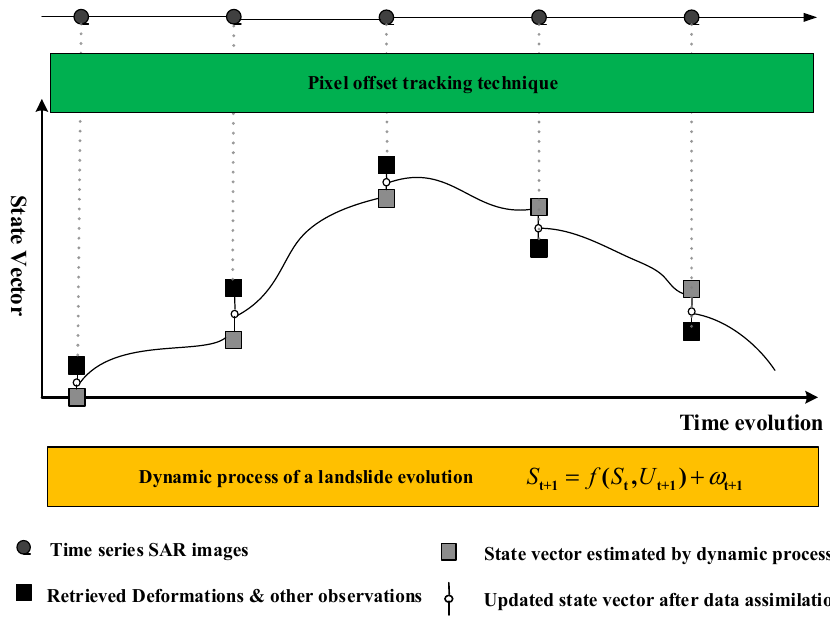
Figure 3. The sequential data assimilation process for this study.